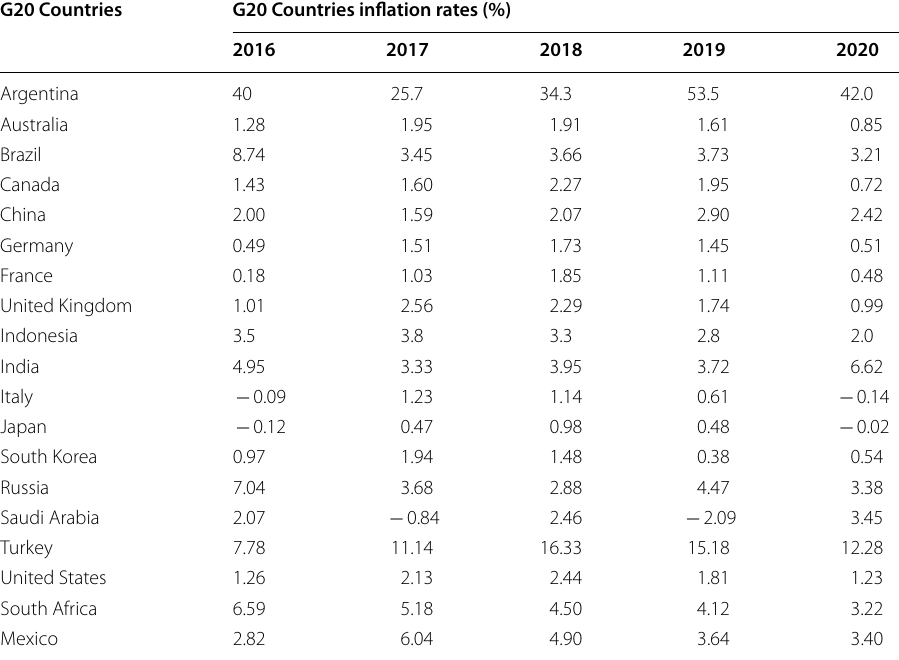
Table 7 The inflation rates (%) of G20 countries (excluding EU) G20